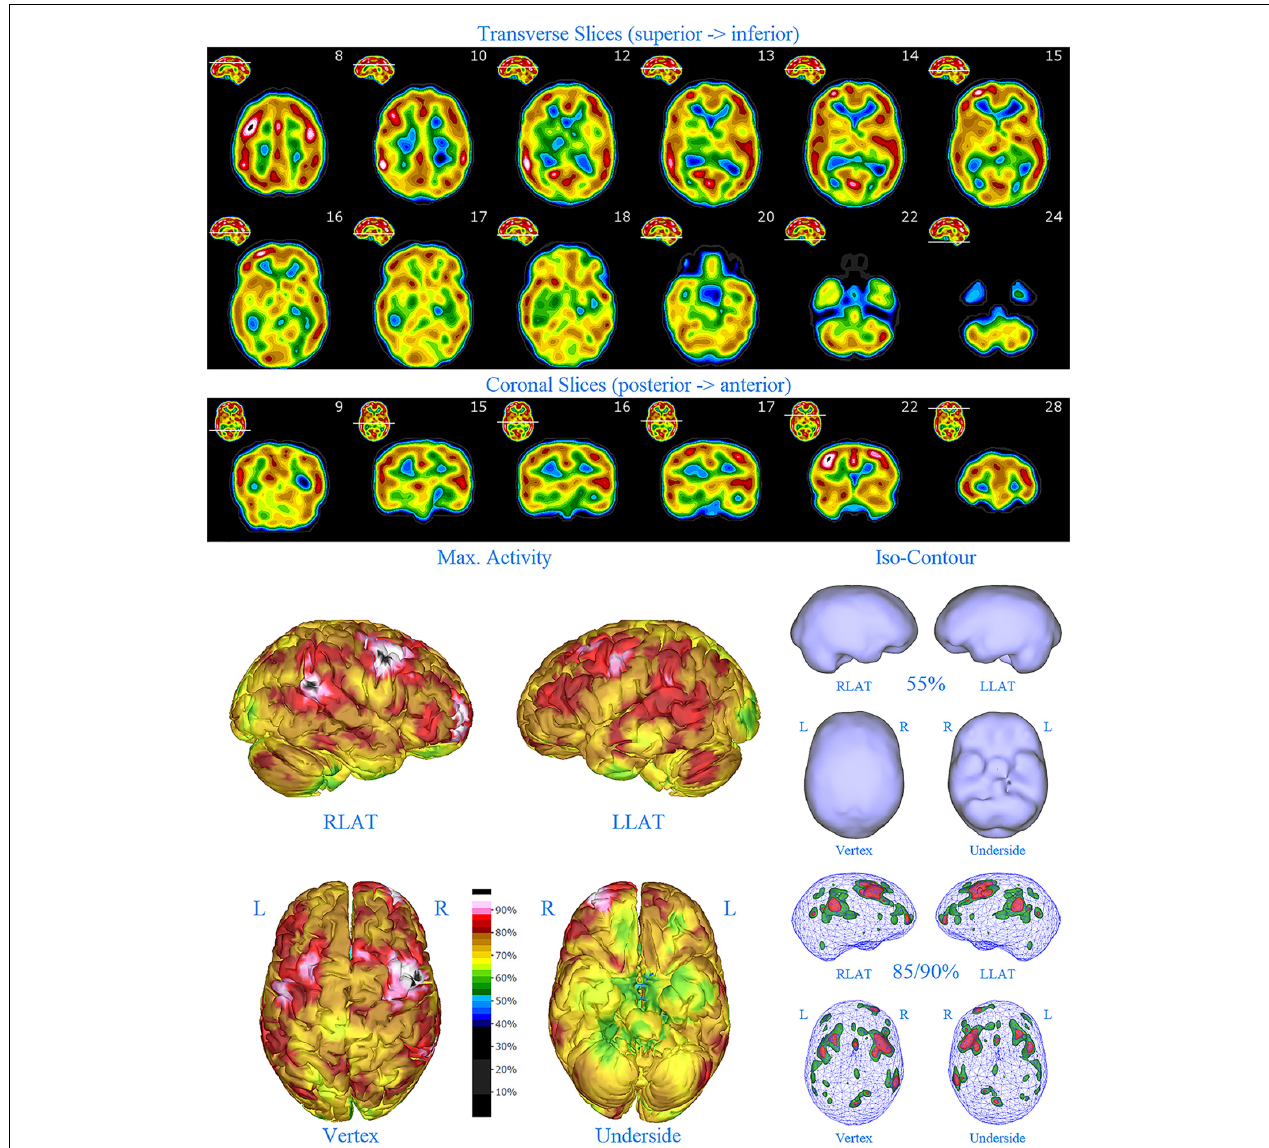
FIGURE 6 | First perfusion SPECT scan of Patient D. Arrangement, color scales, and views are identical to Figure 1 . Anatomical structures such as the thalamus are positioned similarly to the scan shown in Figure 2 . Labeling was eliminated to avoid obscuring the scan details. Perfusion of the thalamus is increased and asymmetrical. Multiple cortical areas of markedly increased perfusion are evident in the right frontal and right parietal